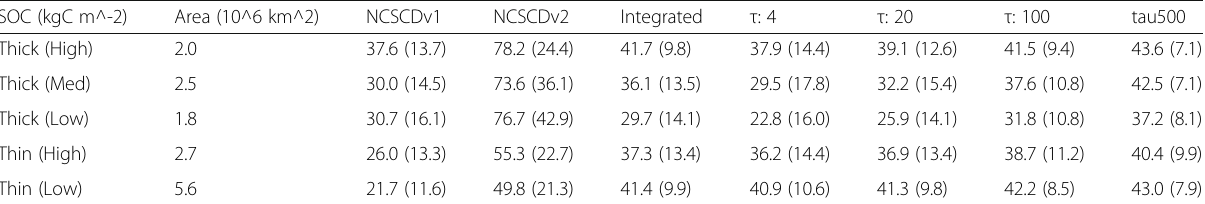
Table 2 Comparison of simulated SOC in the circum-Arctic region for different physiographical subsections. Averaged values in each area are shown with the standard deviation in the parentheses